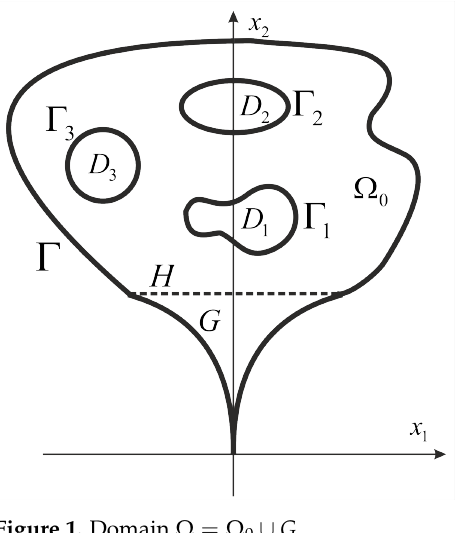
Figure 1. Domain Ω = Ω 0 ∪ G